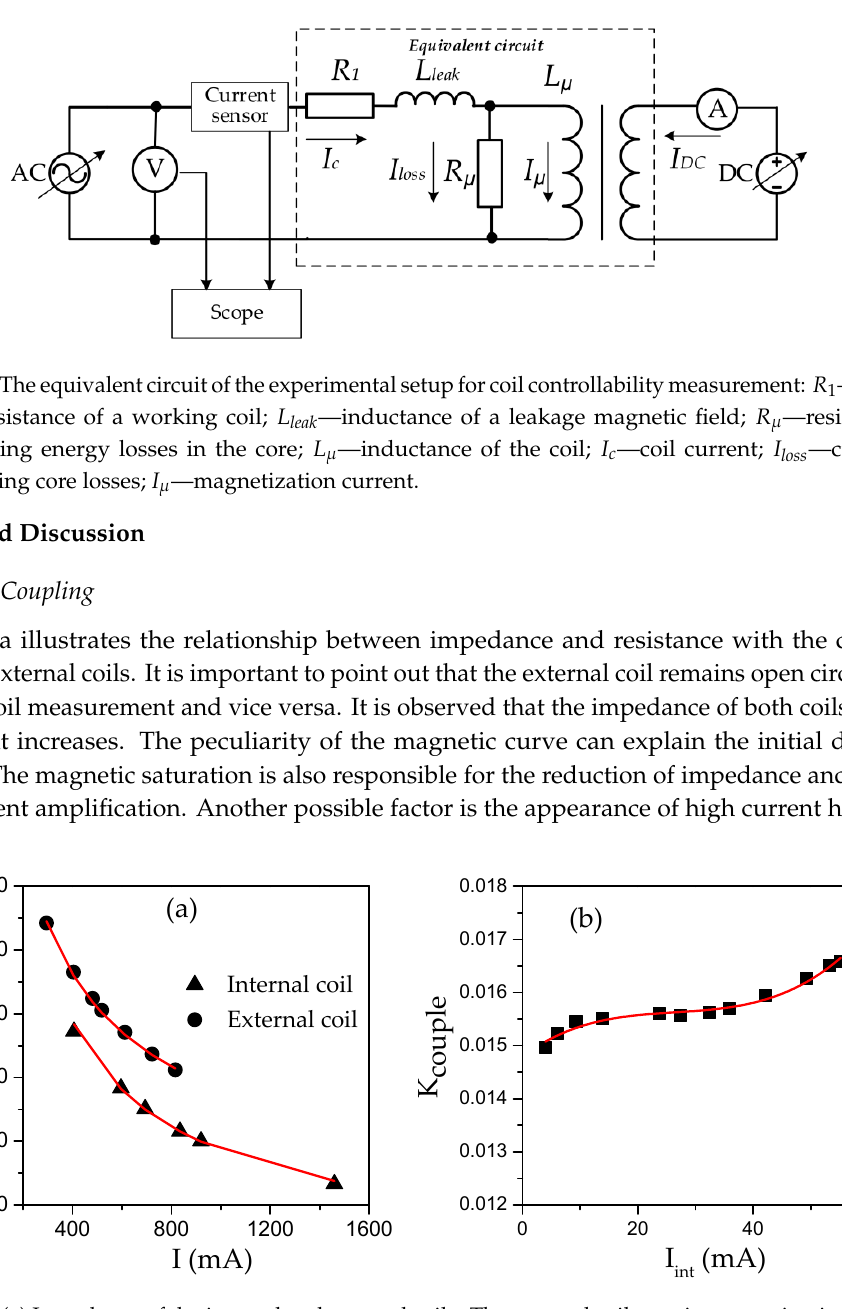
Figure 7. Equivalent resistance of ( a ) external coil and ( b ) internal coil. Solid lines represent the approximation. The approximation coefficient ( (cid:1844) (cid:2870) ) is more than 0.99. 4.3. Controllability Figure 8 represents the I–V curve of control winding immersed in liquid nitrogen. For the measurement, the control DC current is changed from 0 to ~9400 mA. The calculated resistance of working and control coils are ~0.174 Ω and 2.74 Ω , respectively (Figure 8). Copper losses can contribute a significant portion of total ones and interfere with the estimation of ferromagnetic losses.